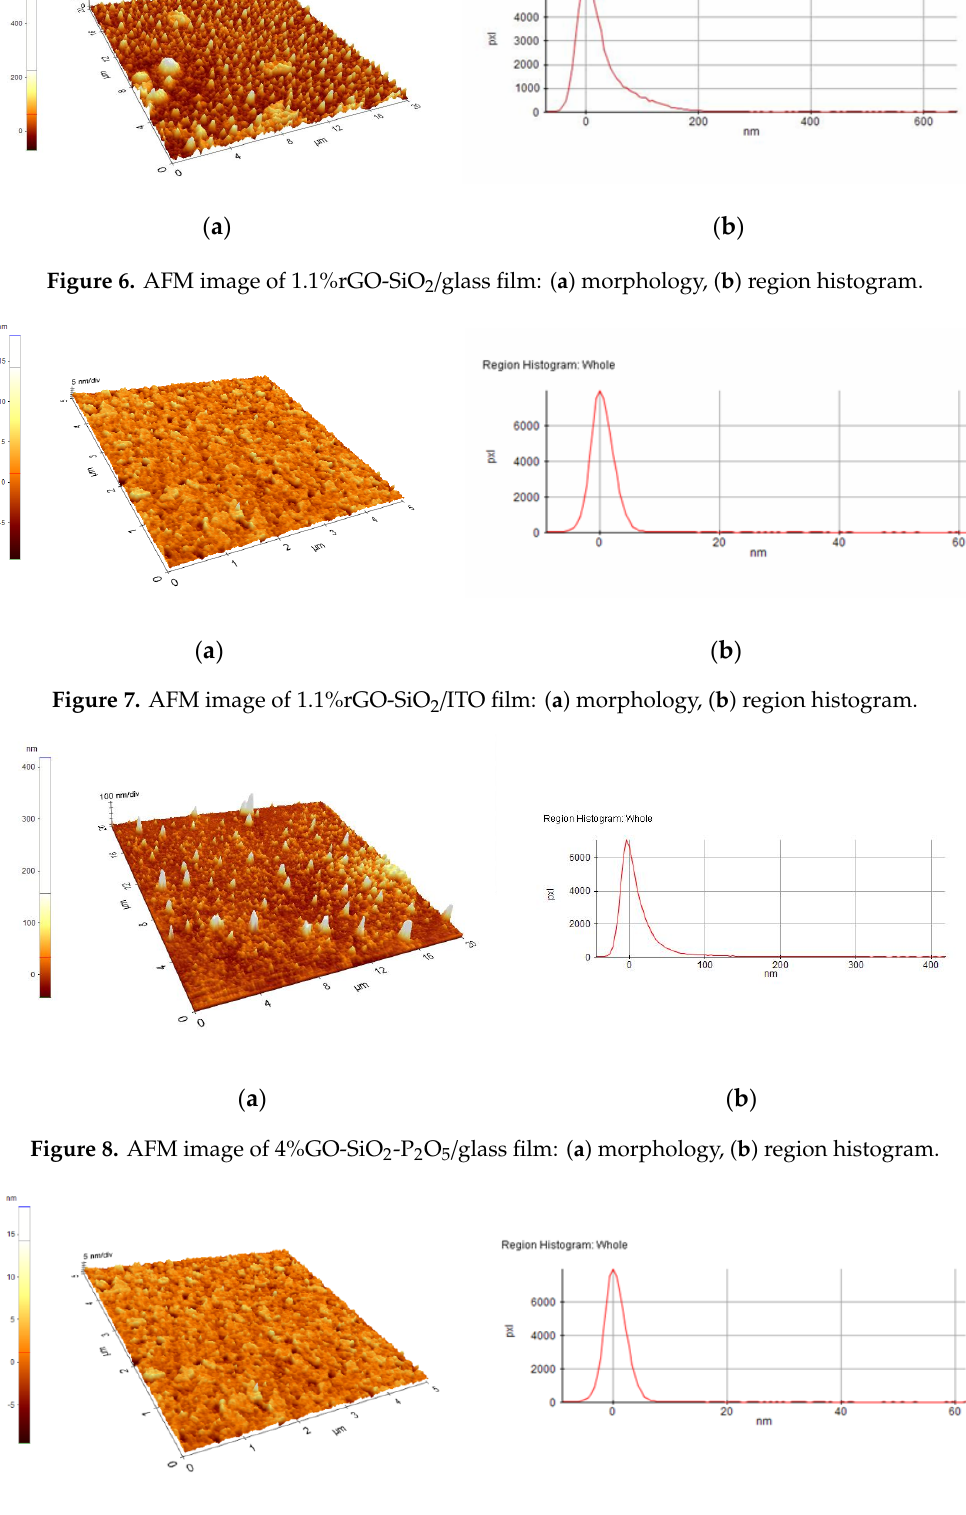
Figure 9. AFM image of 4%GO-SiO 2 -P 2 O 5 /ITO film: ( a ) morphology, ( b ) region histogram.